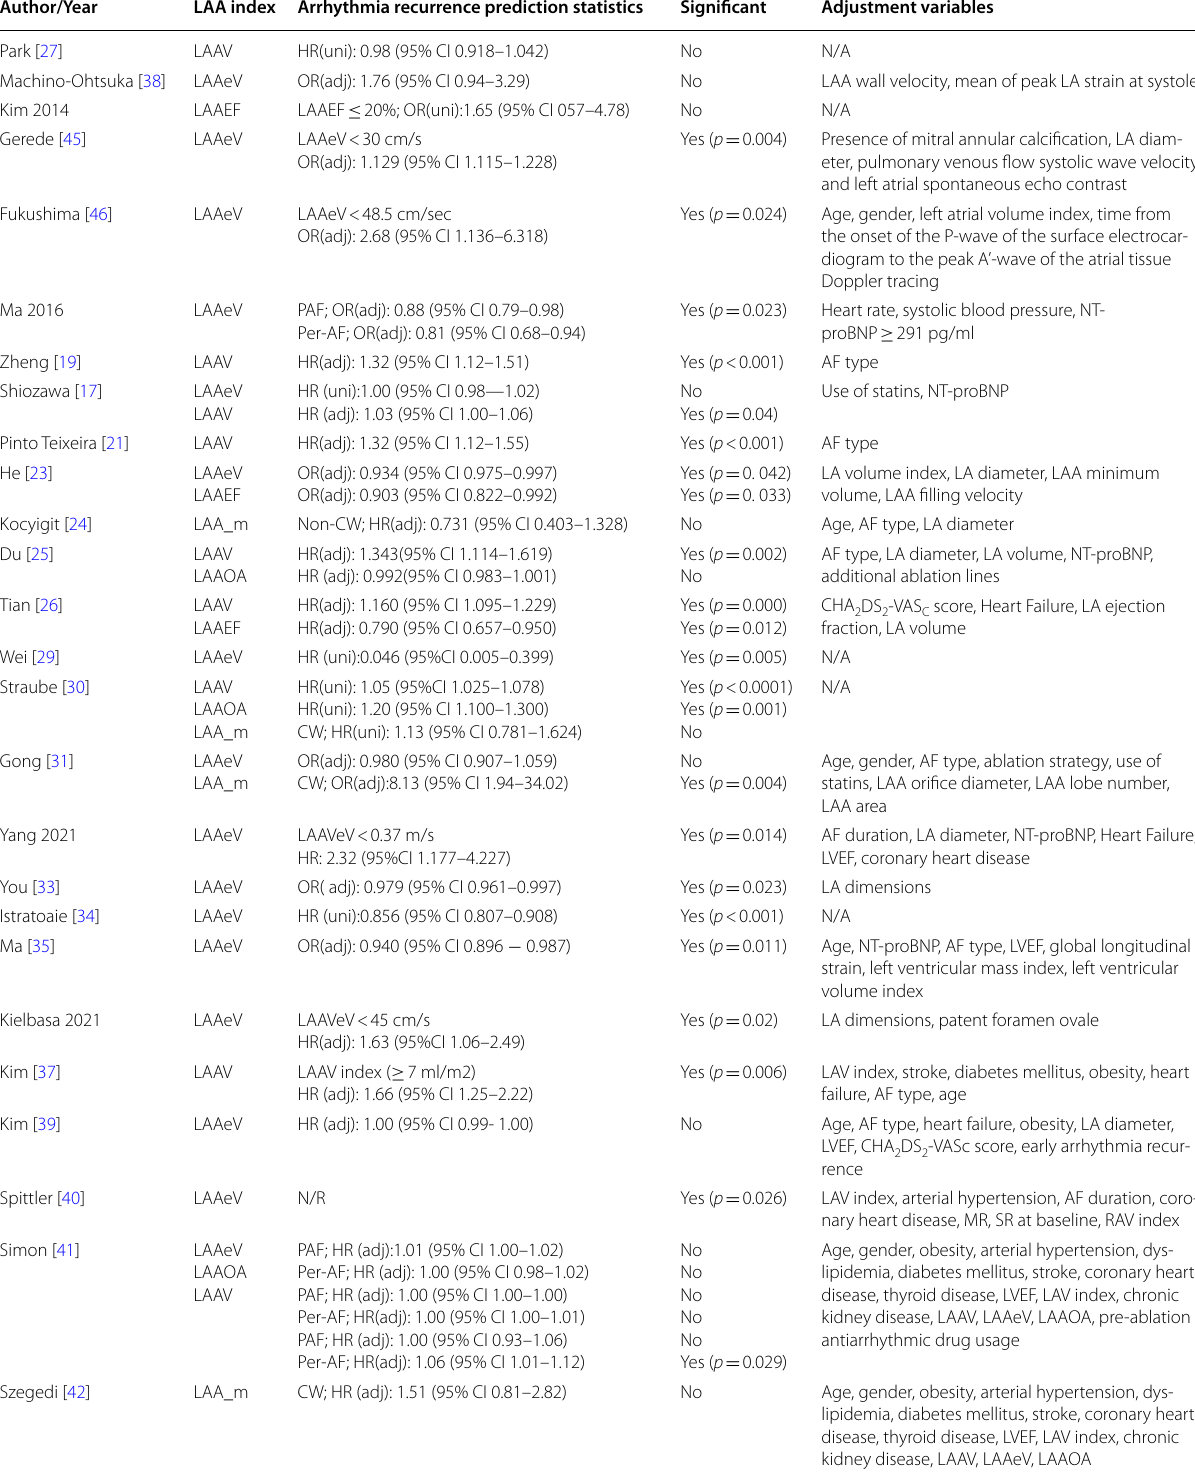
Table 2 Arrhythmia recurrence prediction statistics in each individual